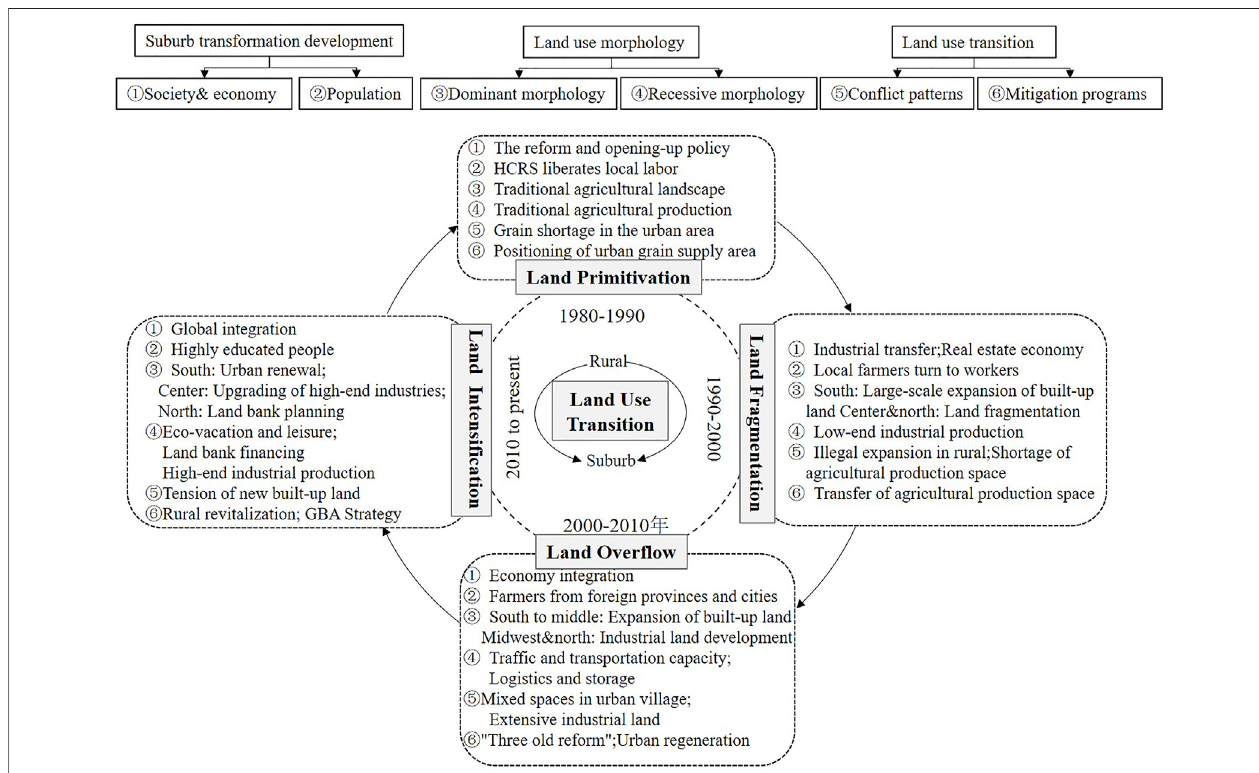
FIGURE8| SuburbandevelopmentpatternsindifferentperiodofBaiyunDistrict.Note: “ Threeoldreform ” referstothetransformationmodeuniquetoGuangdong Province: old town, old factory, and old village transformation. “ HCRS ” refers to the Household contract responsibility system, a form of agricultural production responsibility system in which farmers contract land and other means of production and production tasks from collective economic organizations (mainly villages and groups) on a household basis. “ GBA ” refers to Guangdong-Hong Kong-Macao Greater Bay Area.